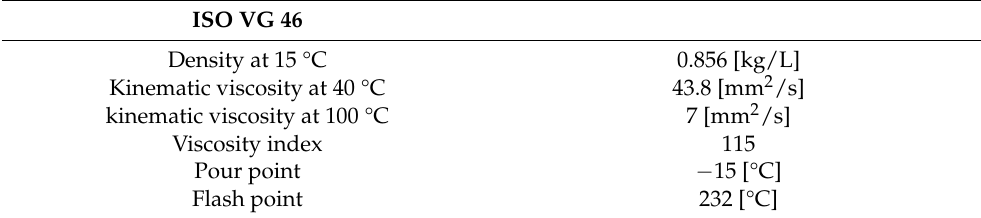
Table 2. Main characteristics of the lubricant ISO VG 46.